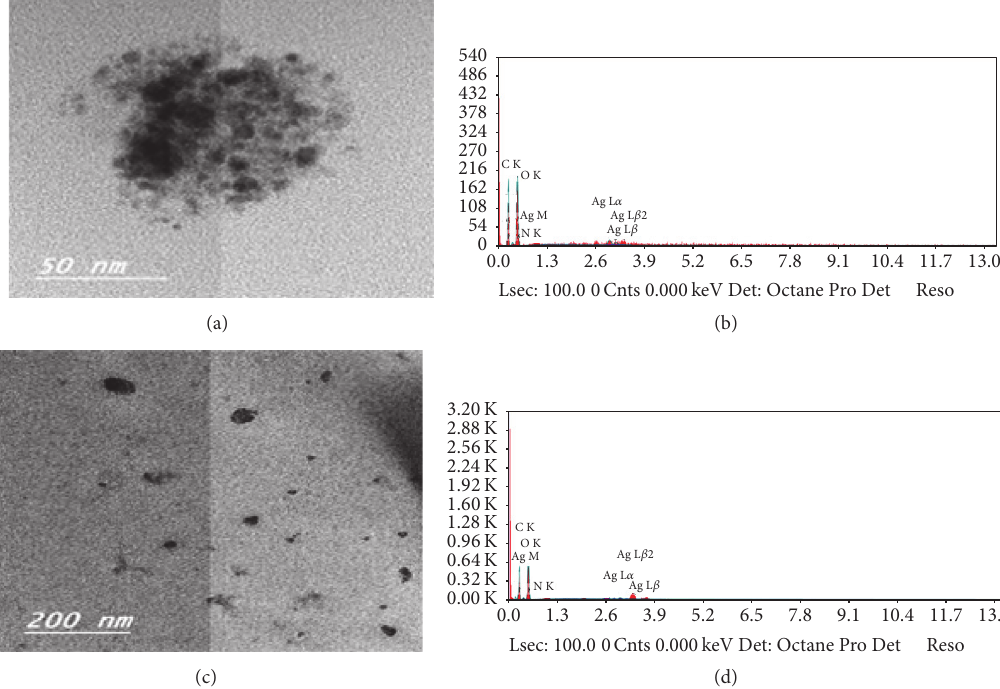
Figure 3: TEM of (a) CS/3-methyl-1H-pyrazole-4-carbaldehyde loaded with AgNPs. (b) EDX of CS/3-methyl-1H-pyrazole-4-carbaldehyde loaded with AgNPs. (c) TEM of CS/1,3-diphenyl-1H-pyrazole-4-carbaldehyde loaded with AgNPs. (d) EDX of CS/1,3-diphenyl-1H-pyrazole- 4-carbaldehyde loaded with